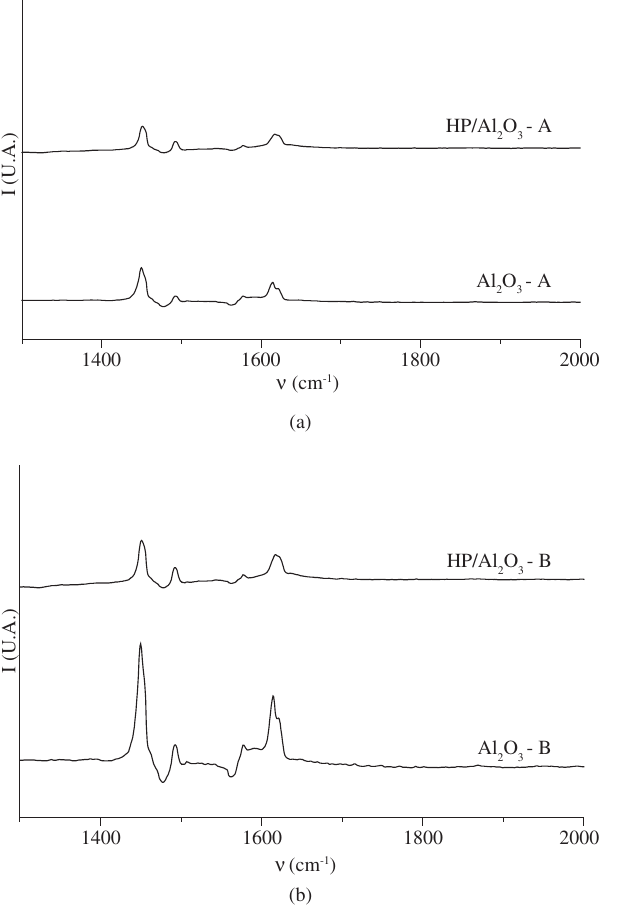
Figura 2. IR spectra after pyridine adsorption on a) Al based